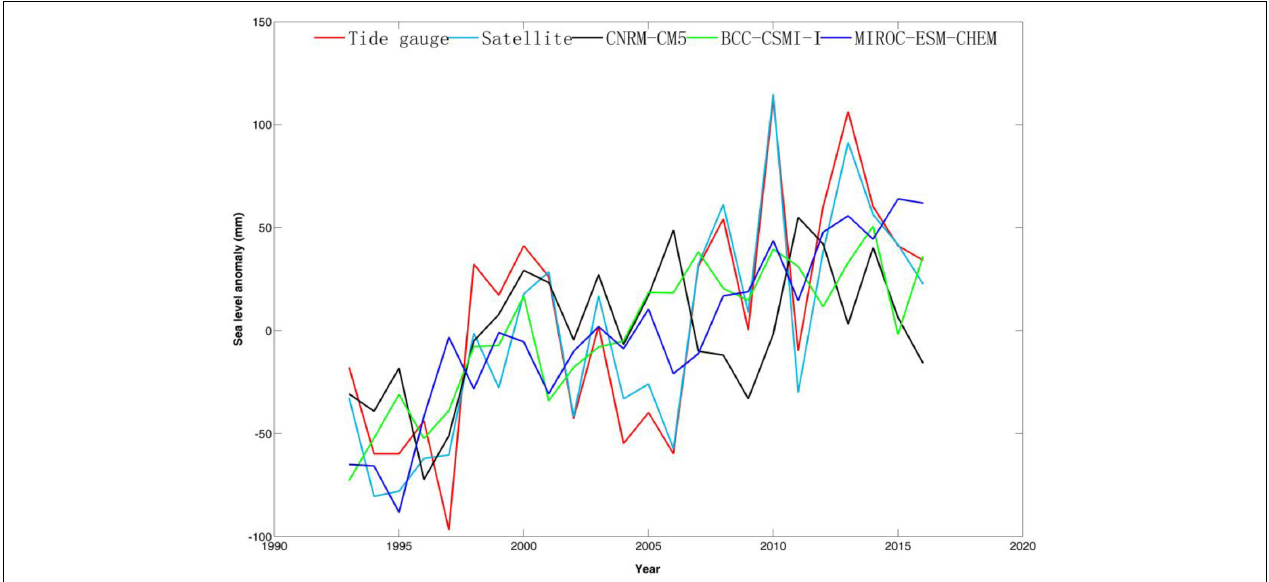
FIGURE 2 | The sea level anomaly calculated using the data from the tide gauge, the satellite, CNRM-CM5, BCC-CSMI-l, and MIROC-ESM-CHEM during 1993 and 2016.